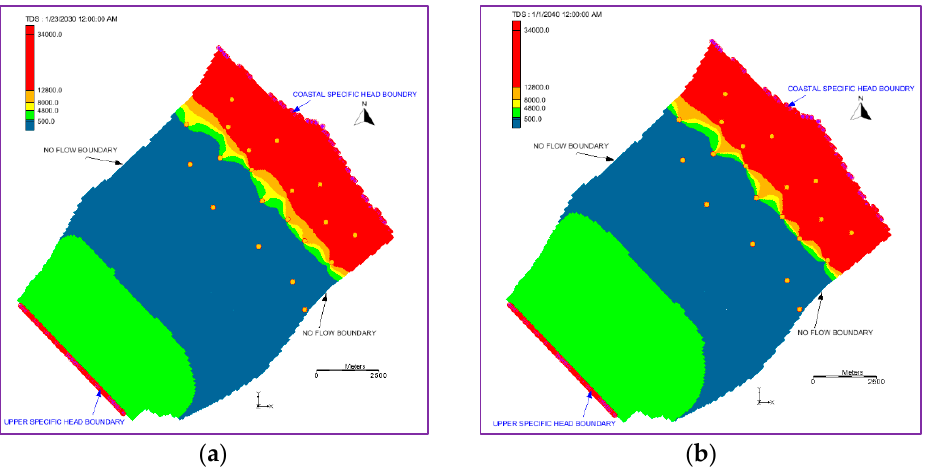
Figure 8. Salinity contours for Scenario-3 (pumping rates increased by 20% from those in the year 2017). ( a ) 2030 and ( b ) 2040 .